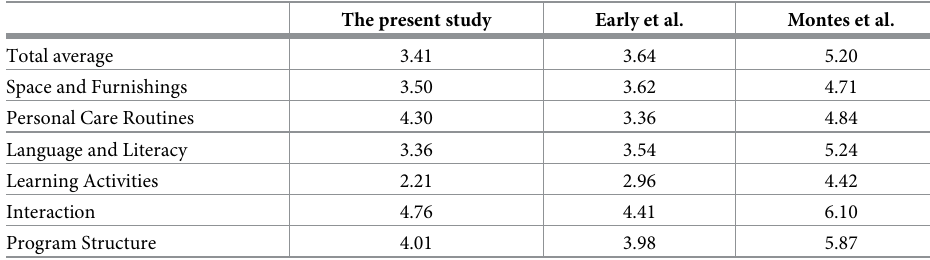
Note. All data from 2017 to 2019 were included in the present study. Scores of Early et al. were calculated by the authors from Table 3 in Early, et al. [38]. Scores for the Montes et al. study were calculated by the authors using Table 1 in Montes, et al.